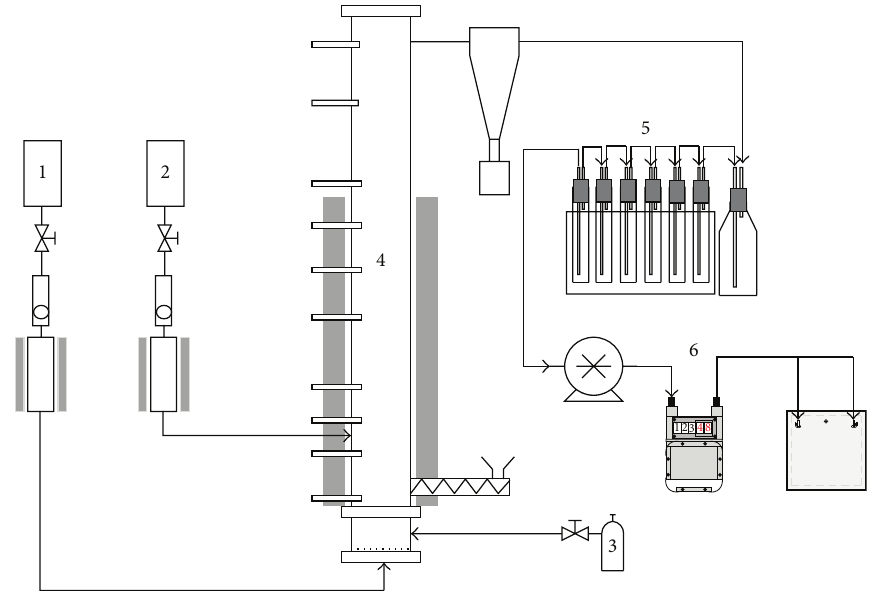
Figure 1: Schematic diagram of gasification reactor: (1) air supply, (2) steam supply, (3) external heating, (4) fluidized bed reactor, (5) gas conditioning, and (6) gas sampling